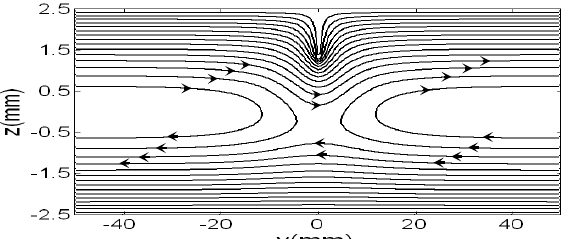
Figure 5: Currents lines in the plate with a perpendicular zero volume crack between A ’ and B ’ which represent the additional combination of figures 2 (b) and